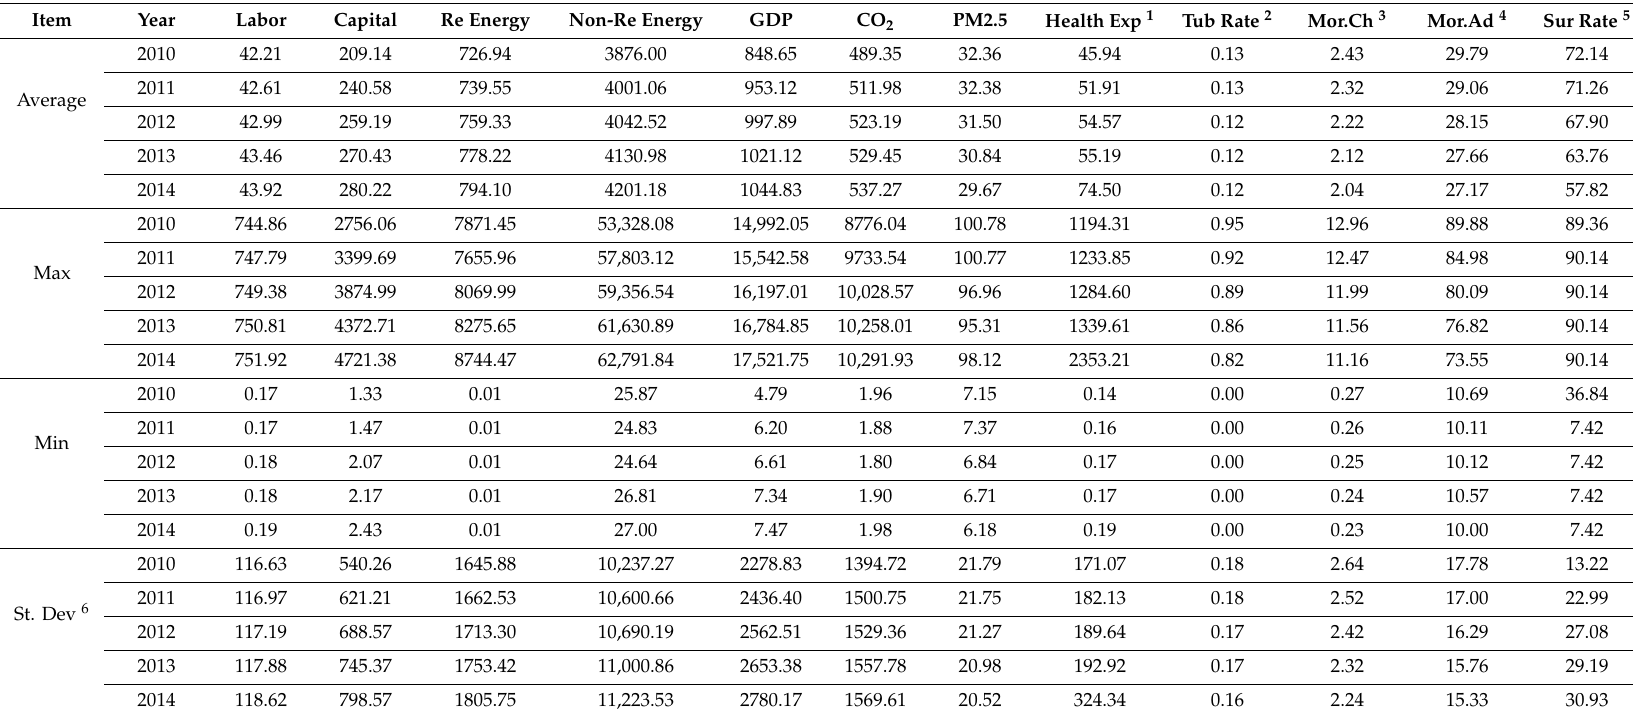
Table 4. Statistics of input and output variables of non-EU